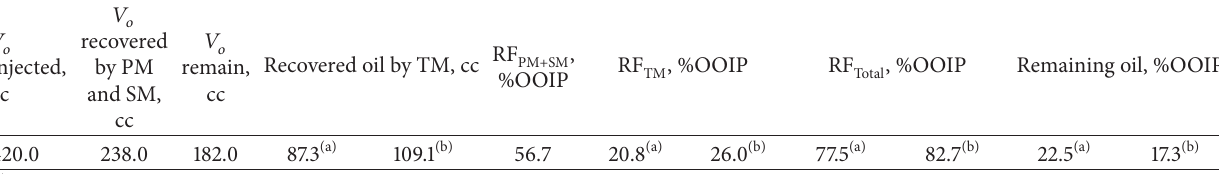
Table 14: Secondary and tertiary recovery factors during flooding process.